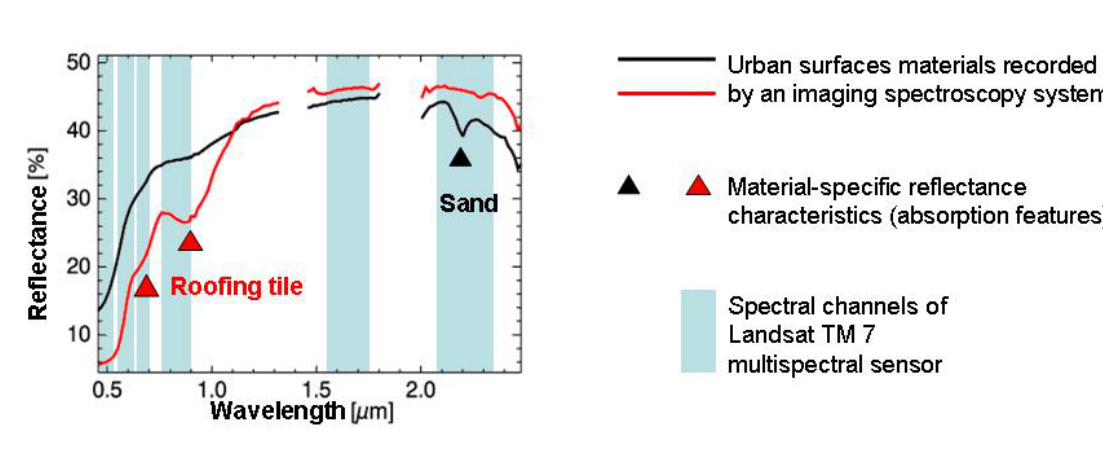
Figure 2. Spectral signatures of typical urban surface materials with its material-specific reflectance characteristics; multispectral systems, such as the Landsat TM 7 sensor, are not able to record the narrow spectral characteristics due to the broad spectral